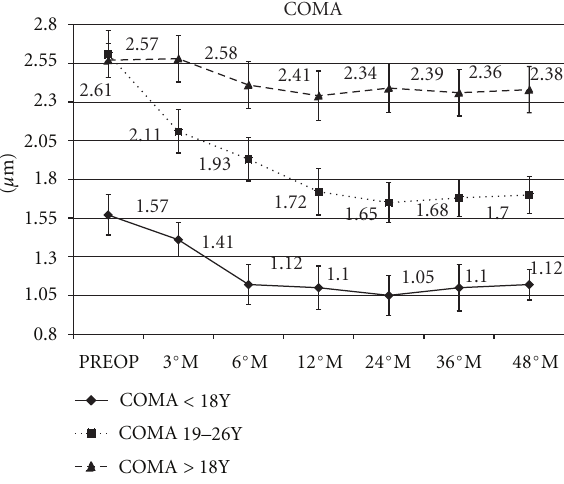
Figure 4: Graph showing anterior corneal surface aberrometry after corneal cross-linking (SAI m) in paediatric patients improved by a mean of, − 0.42 D, − 0.18 D, − 0.24 D, and − 0.10 D; in the intermediate group improved by a mean of, − 1.05 D, − 1.14 D, − 0.84 D, and − 0.65 D; in adult group improved by a mean of, − 0.52 D, − 1.0 D, − 0.17 D, and − 1.11 D.